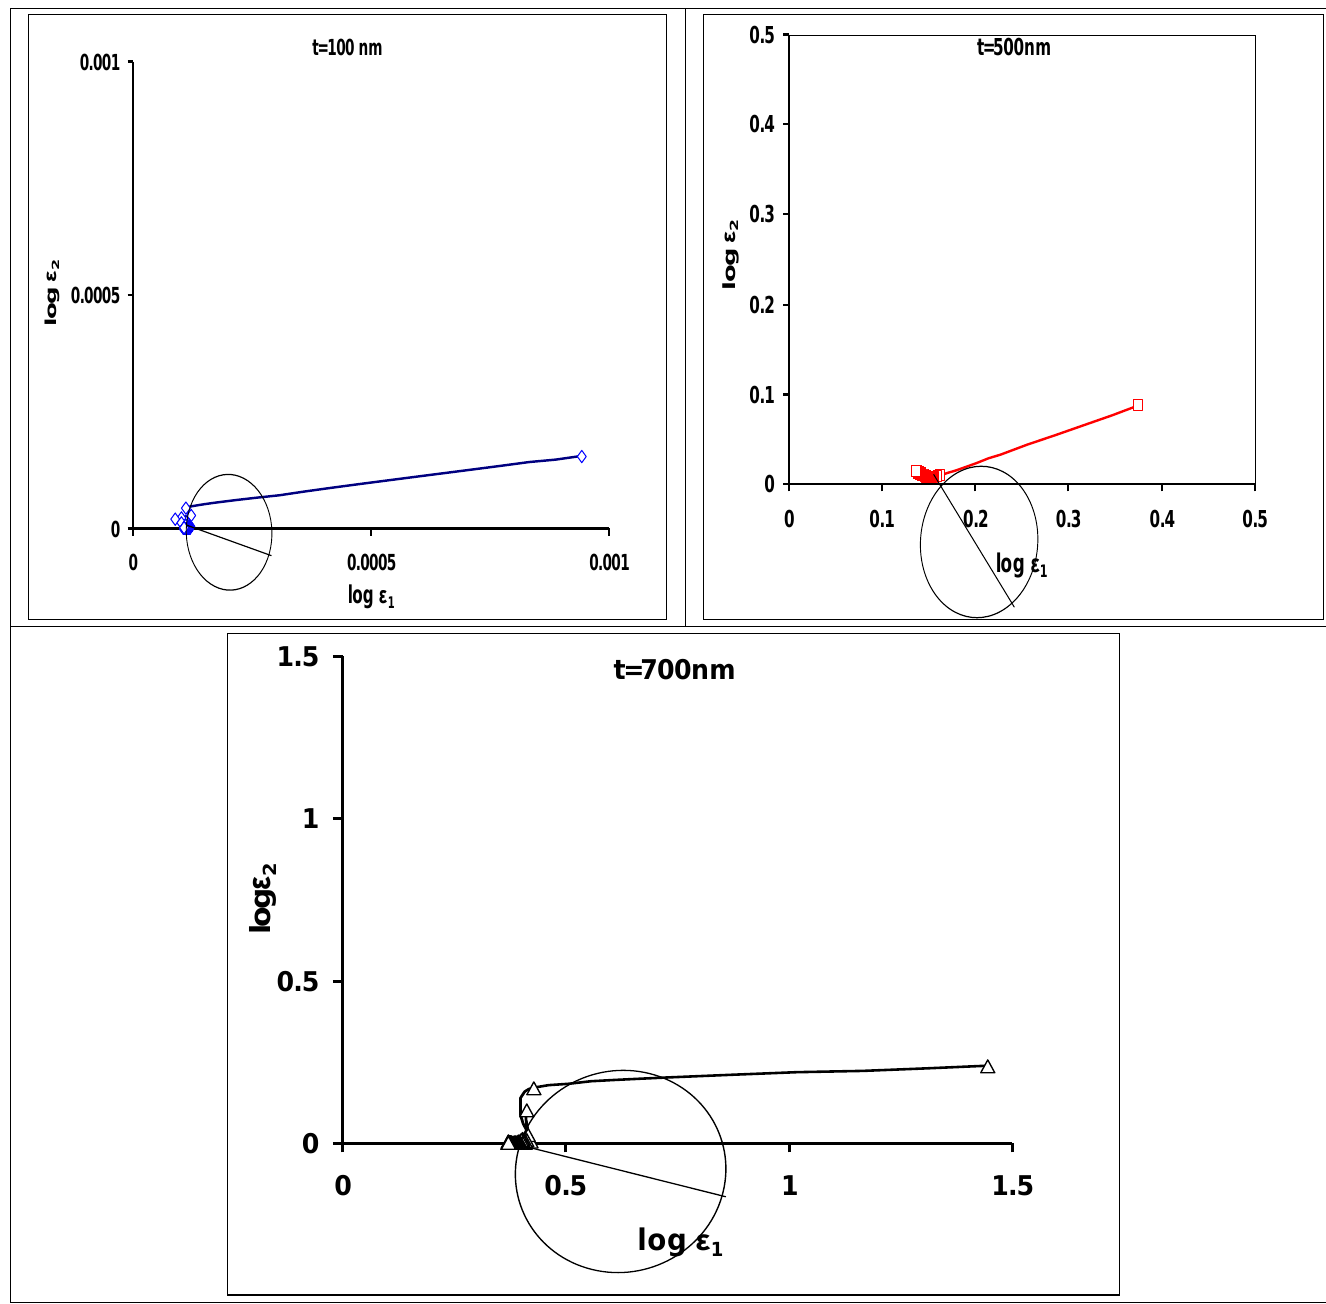
Fig. 6: Cole –Cole Diagram of for Bi